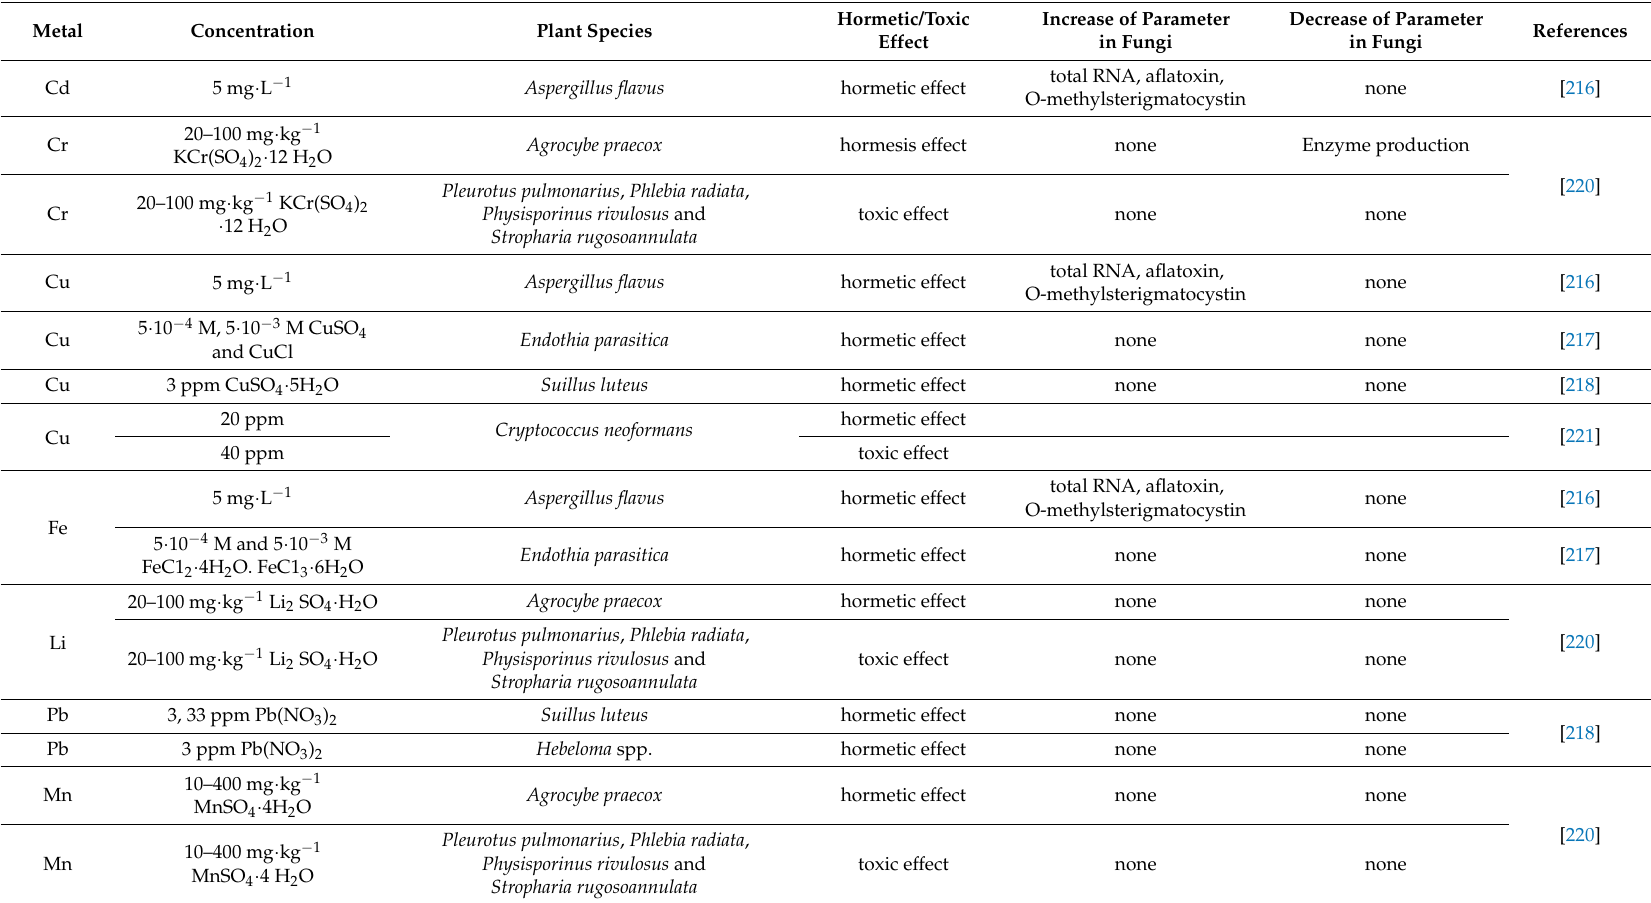
Table 3. Effects of heavy metals at hormetic and toxic dose on